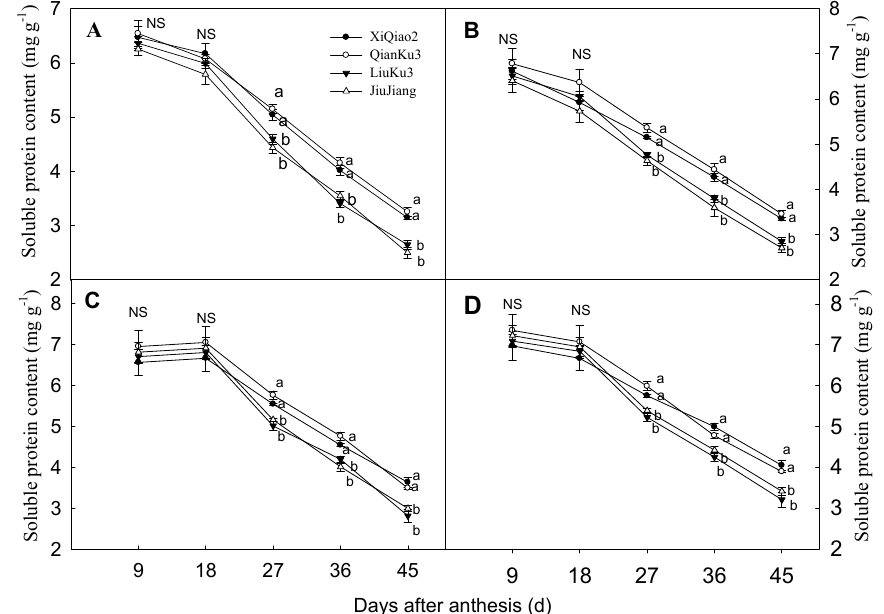
Figure 2. Soluble protein (SP) content in the leaves of four Tartary buckwheat cultivars at different flowering nodes. Panels ( A – D ) show results for the leaves of the 6th, 7th, 8th, and 9th flowering nodes, respectively. Data are means ± SD of two years (2016 and 2017). Letters a and b denote significant differences between cultivars ( p < 0.05) at the same day after anthesis. NS: no significant